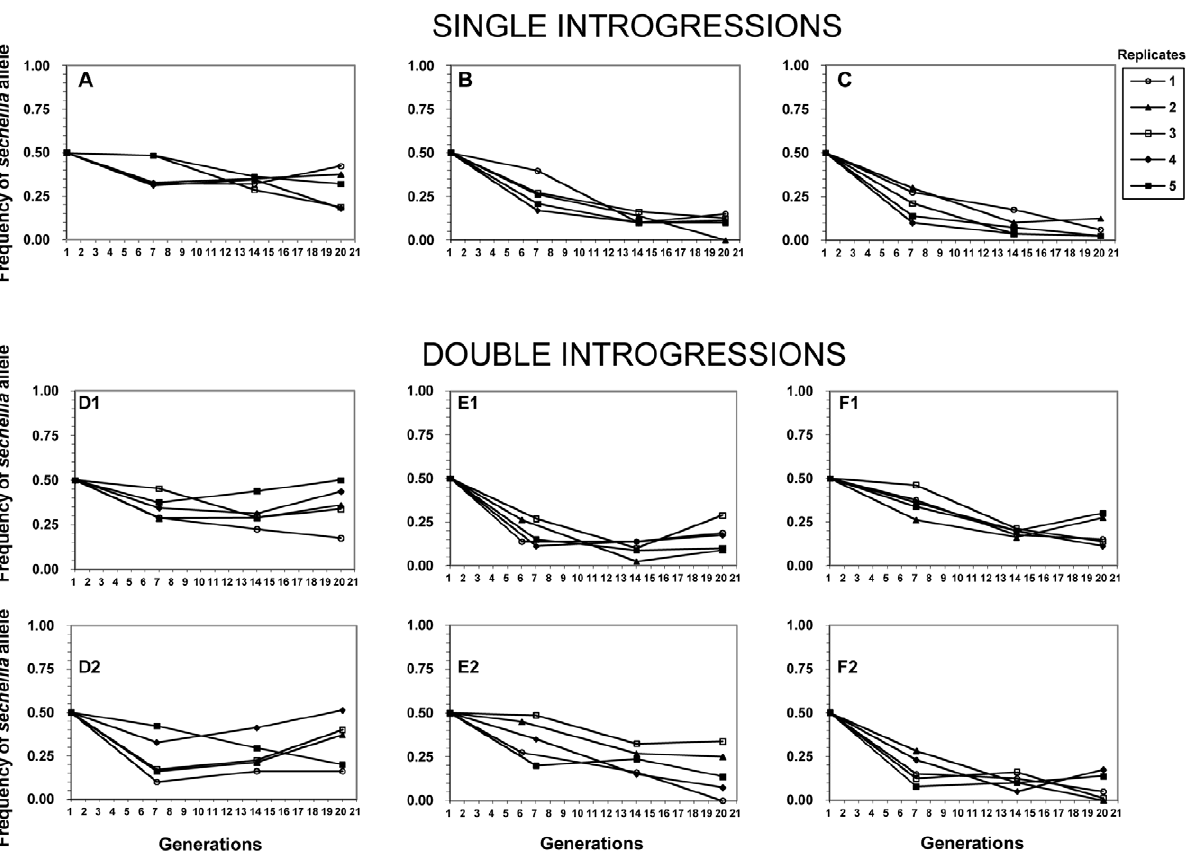
Figure 2. Frequencies of the nine sechellia markers in the six competition experiments over 20 generations. X-axis: generations. Y-axis: frequencies of sechellia markers. Each plot monitors the frequency of a single sechellia introgression relative to its simulans counterpart. A–C plots represent experiments with only a single introgression per genotype, while D1–F2 plots represent experiments with two sechellia introgressions per genotype, even though each plot follows only a single introgression/marker. Five experimental replicates for each marker. See Figure S1 for introgression details.